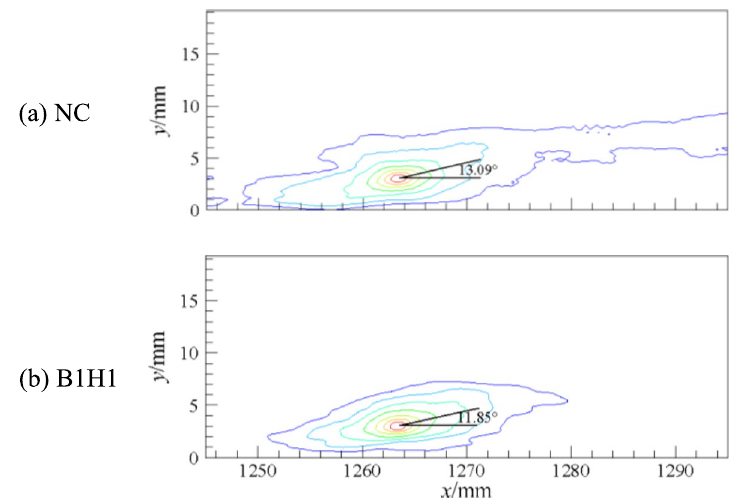
Fig. 19 Two-point correlation coefficient of streamwise fluctuating velocity in x - y